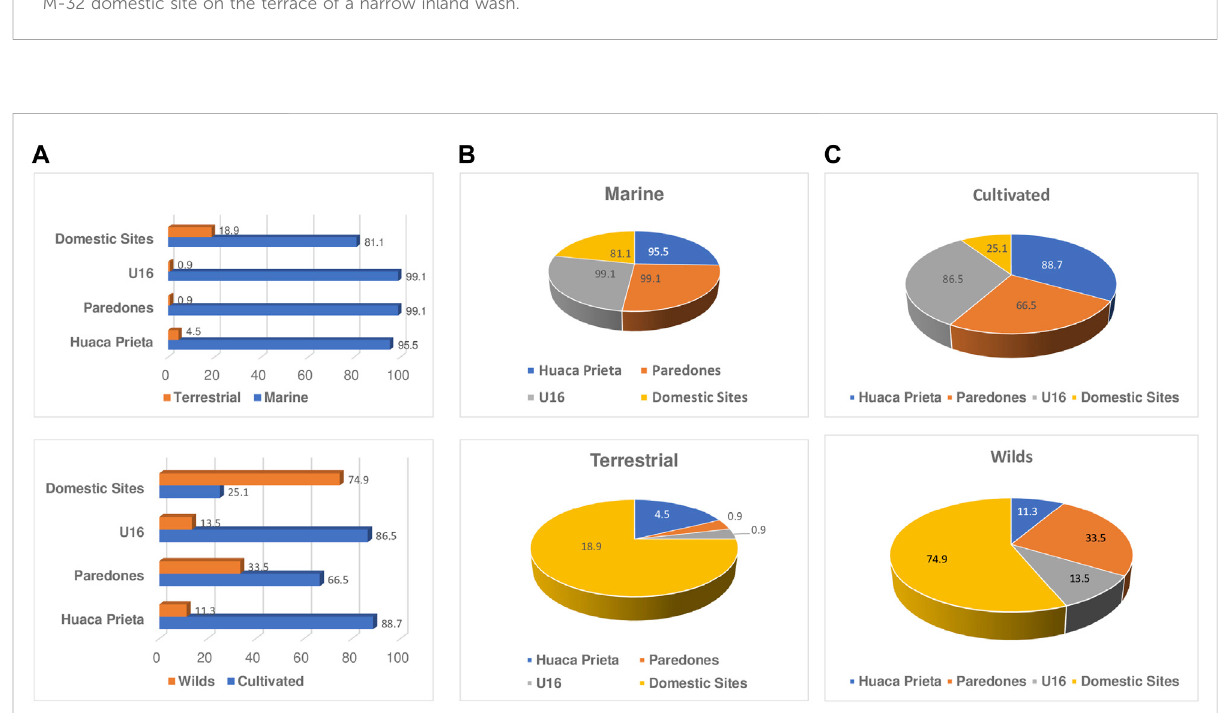
FIGURE 13 (A) Postholesofoval-shaped hutatdomesticSiteS-11onabeachridge~5 kmnorthofHuacaPrieta; (B) postholesofrectangularhutlocatedat M-32 domestic site on the terrace of a narrow inland wash.